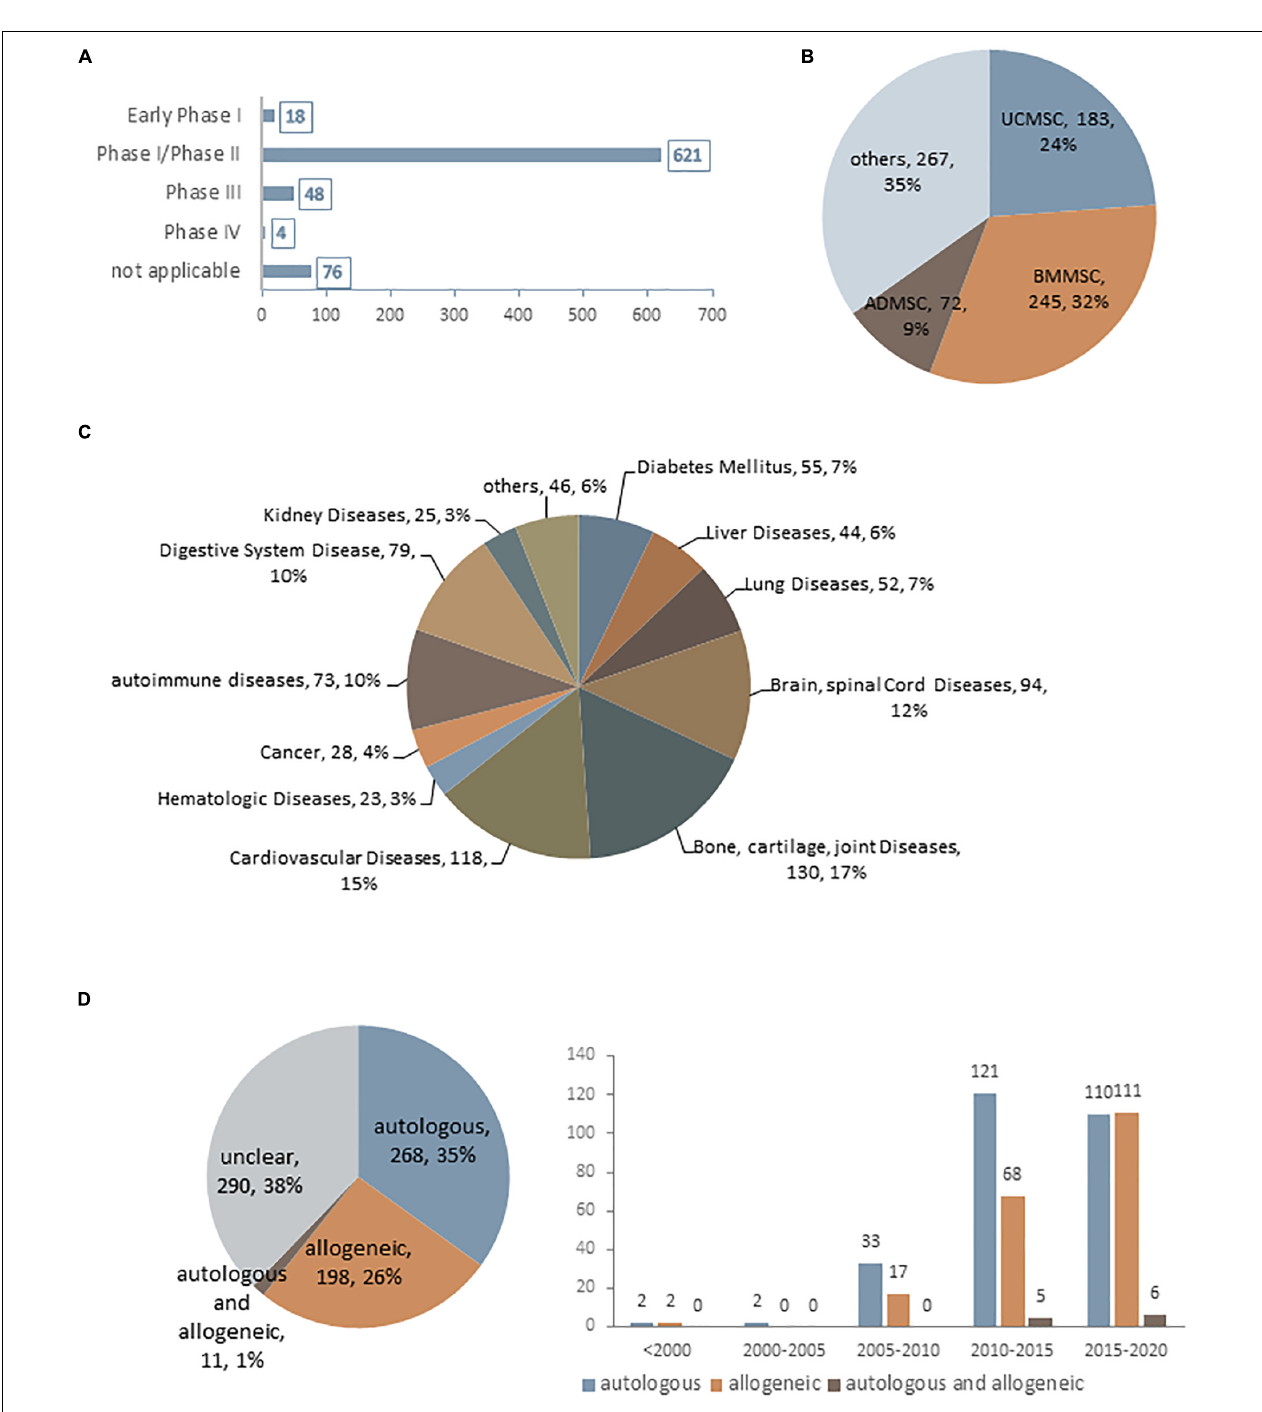
FIGURE 1 | Current statistical data for MSC-based clinical trials as of January 2020 (data accessed from ClinicalTrials.gov ∼ 2020.1). (A–D) Statistics for MSC-based clinical trials in different phases (A) , using difference cell sources (B) , in different disease states (C) , and using autologous or allogeneic transplantation (D) .